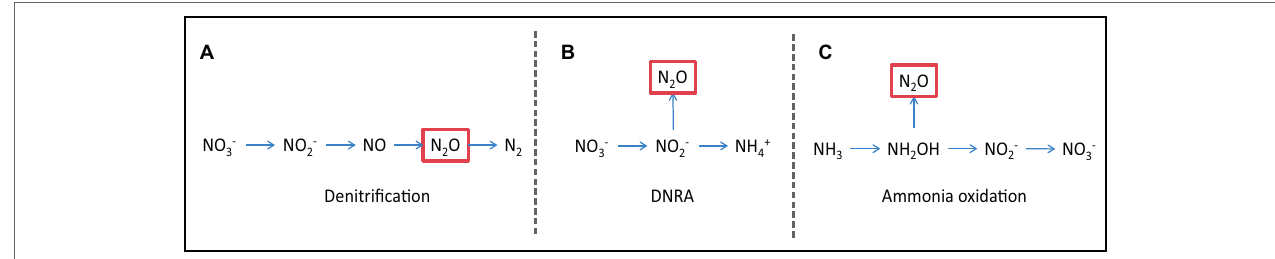
FIGURE 3 | Nitrous oxide emissions. Simplified overview of N 2 O (nitrous oxide)-producing processes that can be influenced by AM fungi. (A) Denitrification, (B) dissimilatory nitrate reduction to ammonium (DNRA), (C) ammonia